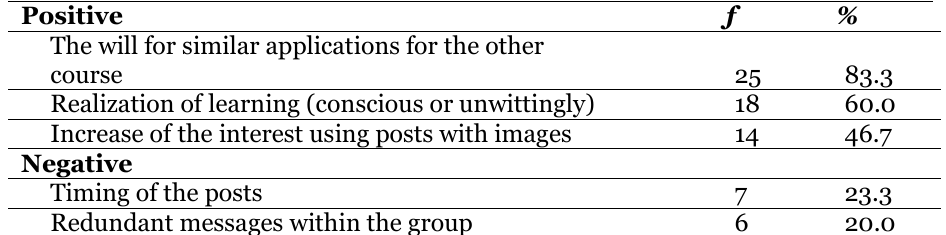
Students’ Opinions About Sending Information Messages via